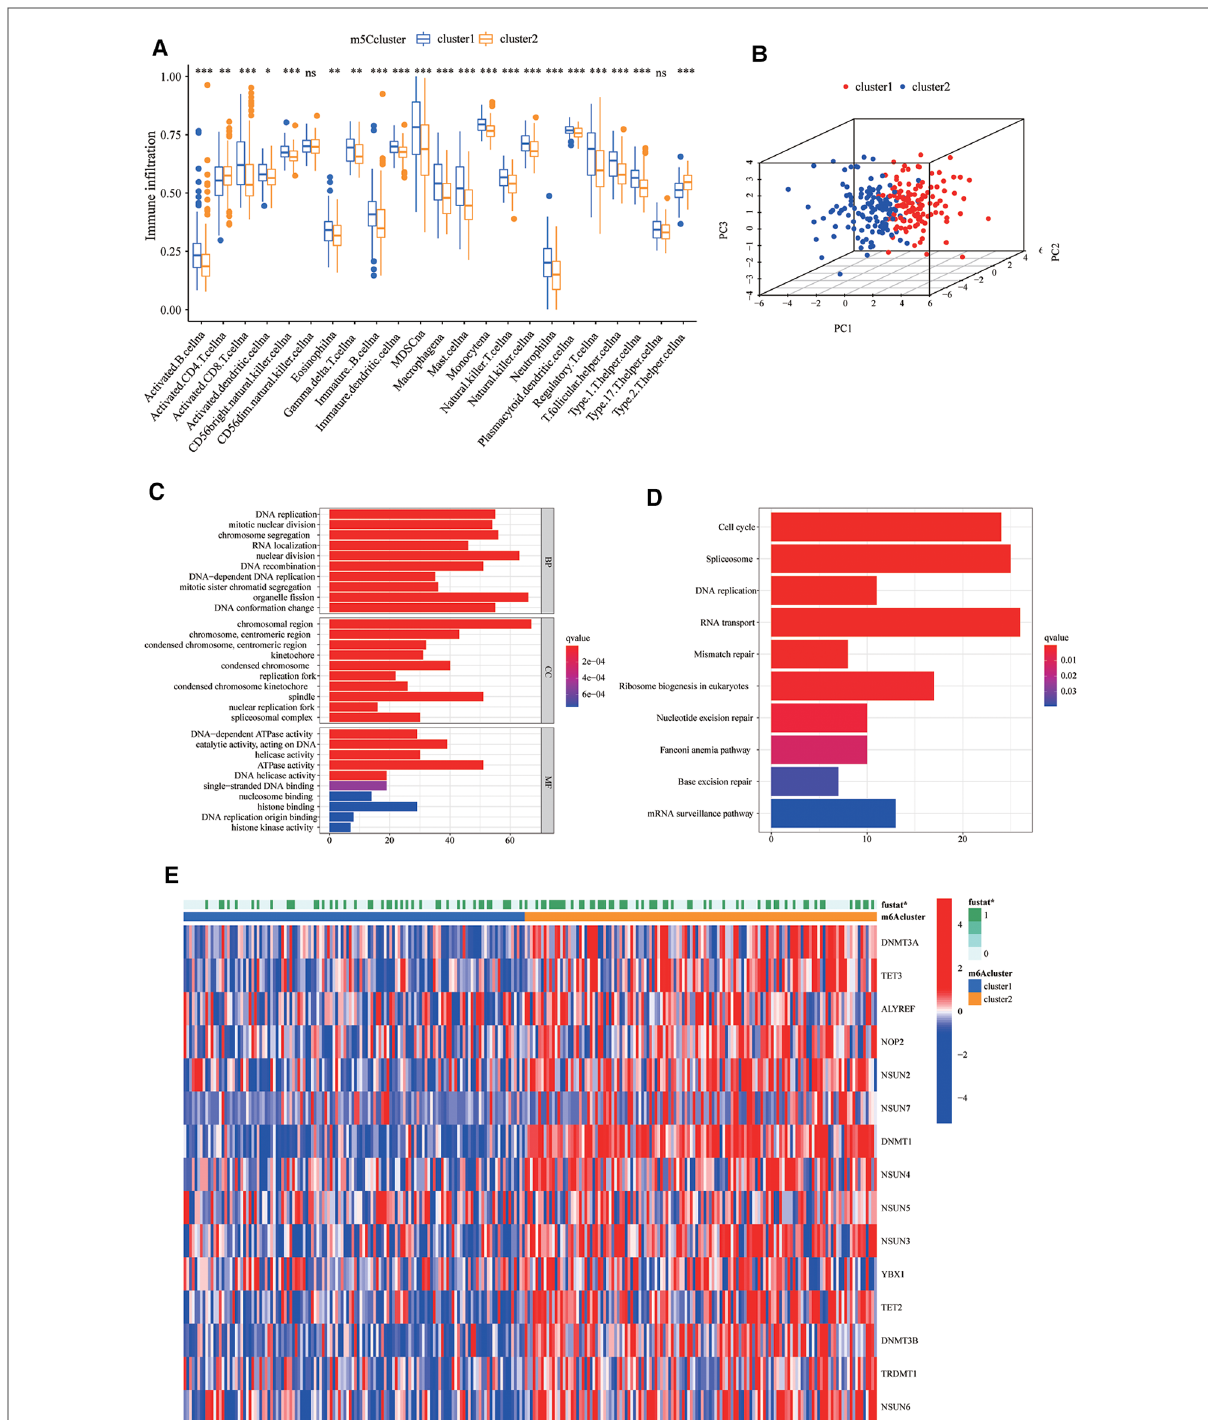
FIGURE 2 Biological differences and differentially expressed genes (DEGs) between clusters of m5C regulators. ( A ) The differences in the enrichment of 28 immune cell species between the two groups. The boxplot extends from the 25th percentile to the 75th percentile, with the center parallel line indicating the median. ( B ) Principal component analysis (PCA) plots demonstrate that the 5-methylcytosine (m5C) modi fi cation patterns are signi fi cantly different between the two clusters. ( C,D ) Gene ontology (GO) and Kyoto Encyclopedia of Genes and Genomes (KEGG) pathway enrichment analysis was used to explore the biological information of m5C phenotype-related differentially expressed genes (DEGs). ( E ) The different expression of m5C regulators in two